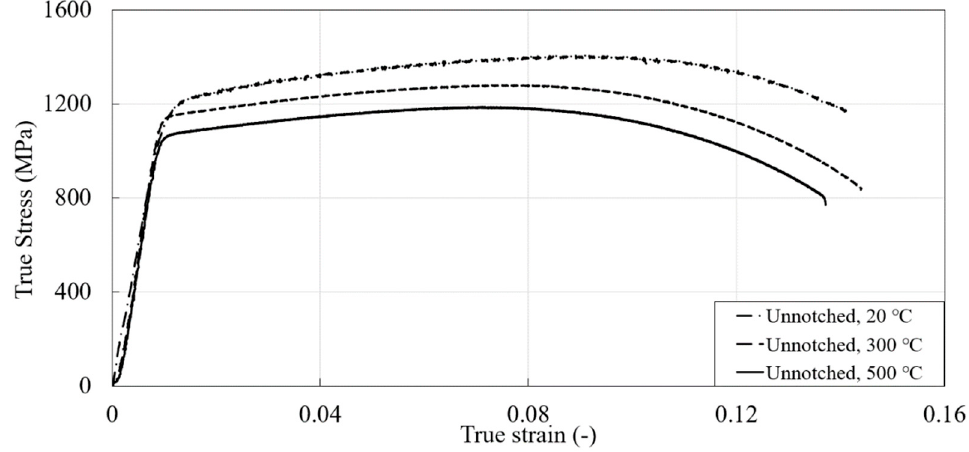
Figure 10. True stress and strain curves of the AISI H13 material for 20, 300, and 500 °C tempera- tures.